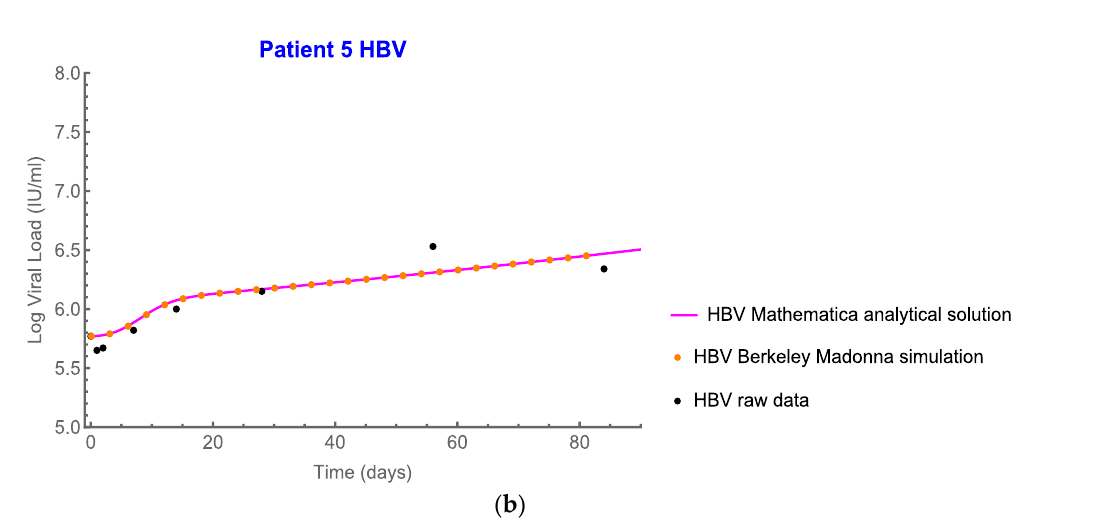
Figure 8. ( a ) shows the HBV Mathematica analytical solution (i.e., Equation (16) herein), HBV Berkeley Madonna fit for patient 5, which was a result of fitting the modified model with measured data using Berkeley Madonna 8. ( b ) follows a similar approach as conducted in 8a but for HDV using D.